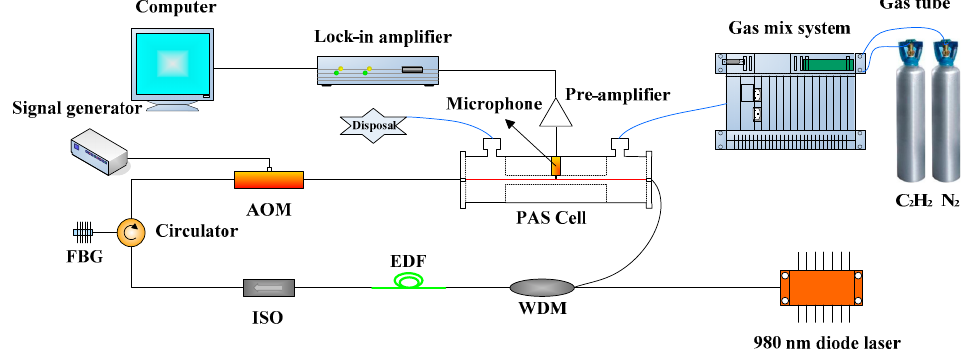
Figure 1. Schematic of the PAS system with acousto-optic Q-switched fiber laser.